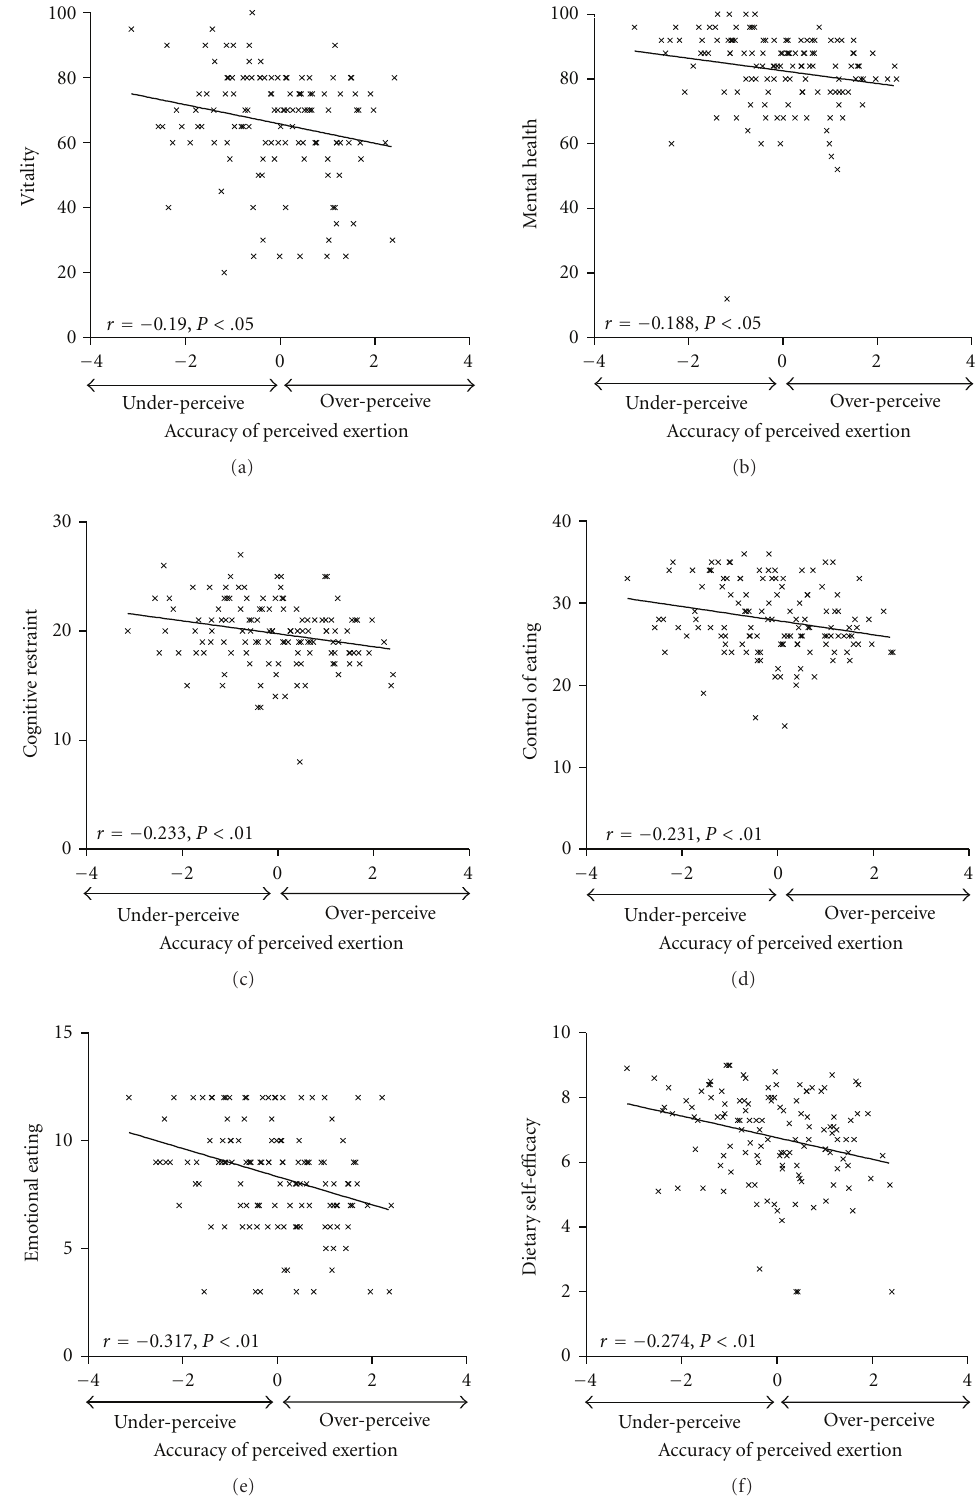
Figure 1: Simple Pearson correlations between accuracy of perceived exertion and vitality (a), mental health (b), cognitive restraint (c), control of eating (d), emotional eating (e), and dietary self-e ffi cacy (f). The overperception of exertion was associated with lower vitality, poorer mental health, less cognitive restraint, less control of eating, more emotional eating, and lower dietary self-e ffi